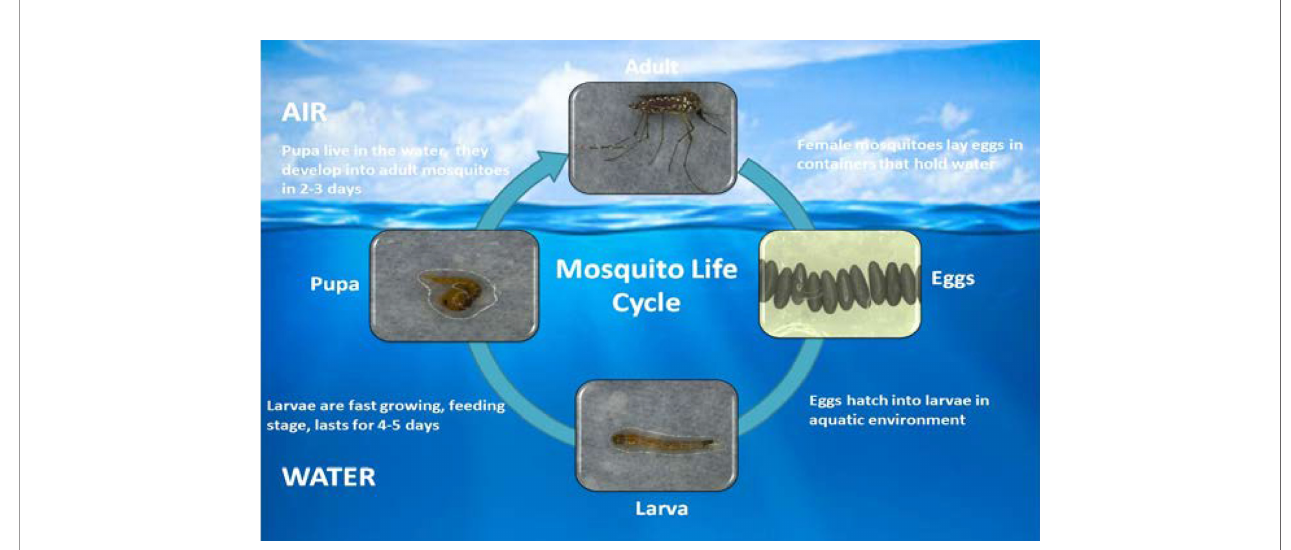
FIGURE 1 | Life cycle of mosquito Aedes aegypti